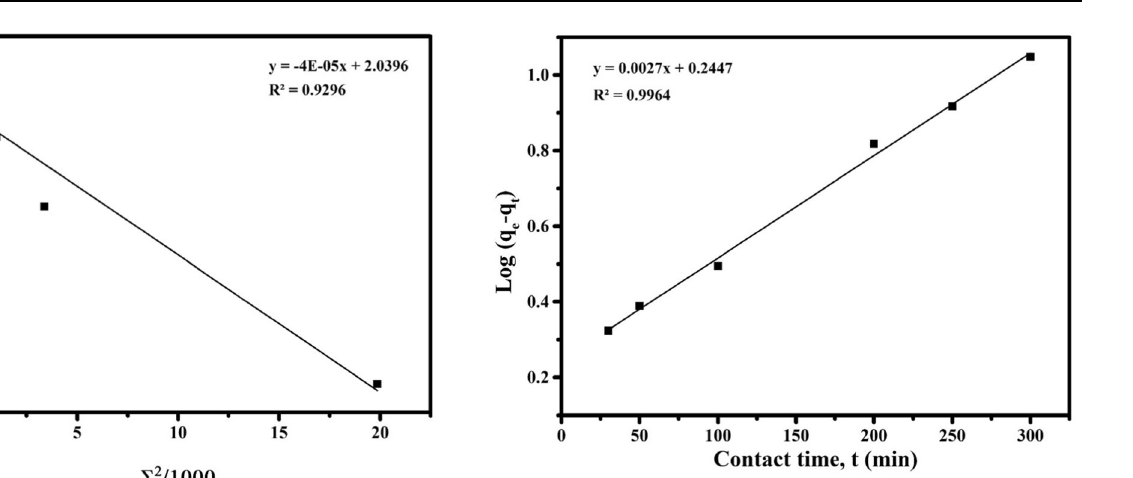
Fig. 10 Dubinin–Radhushkevich adsorption isotherm of MB dye adsorption on the PBF surface